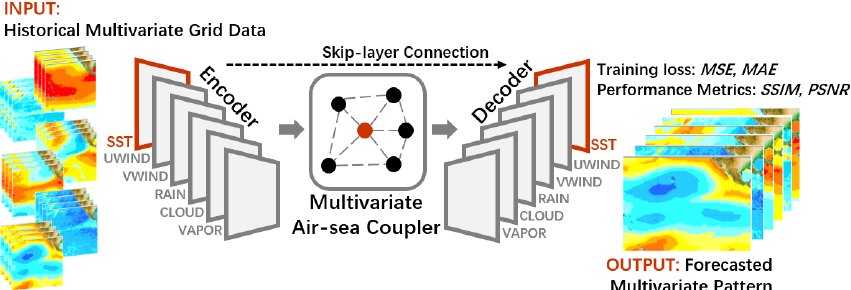
Figure 3. The structure of ENSO-ASC. There are six encoders for the chosen variables to extract spatial–temporal information and a multivariate air–sea coupler to simulate interactions. After interactions, we design six decoders to restore the major variable SST and other variables. The training loss and performance metrics are also displayed.